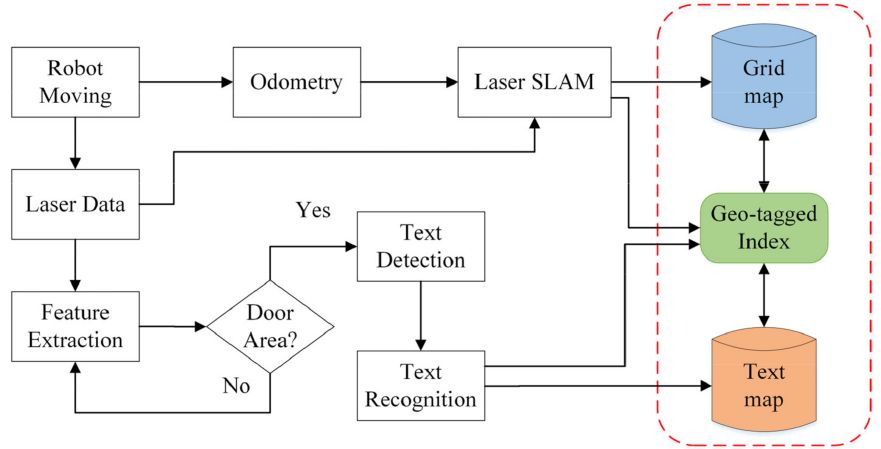
Figure 5. Map-building procedure.